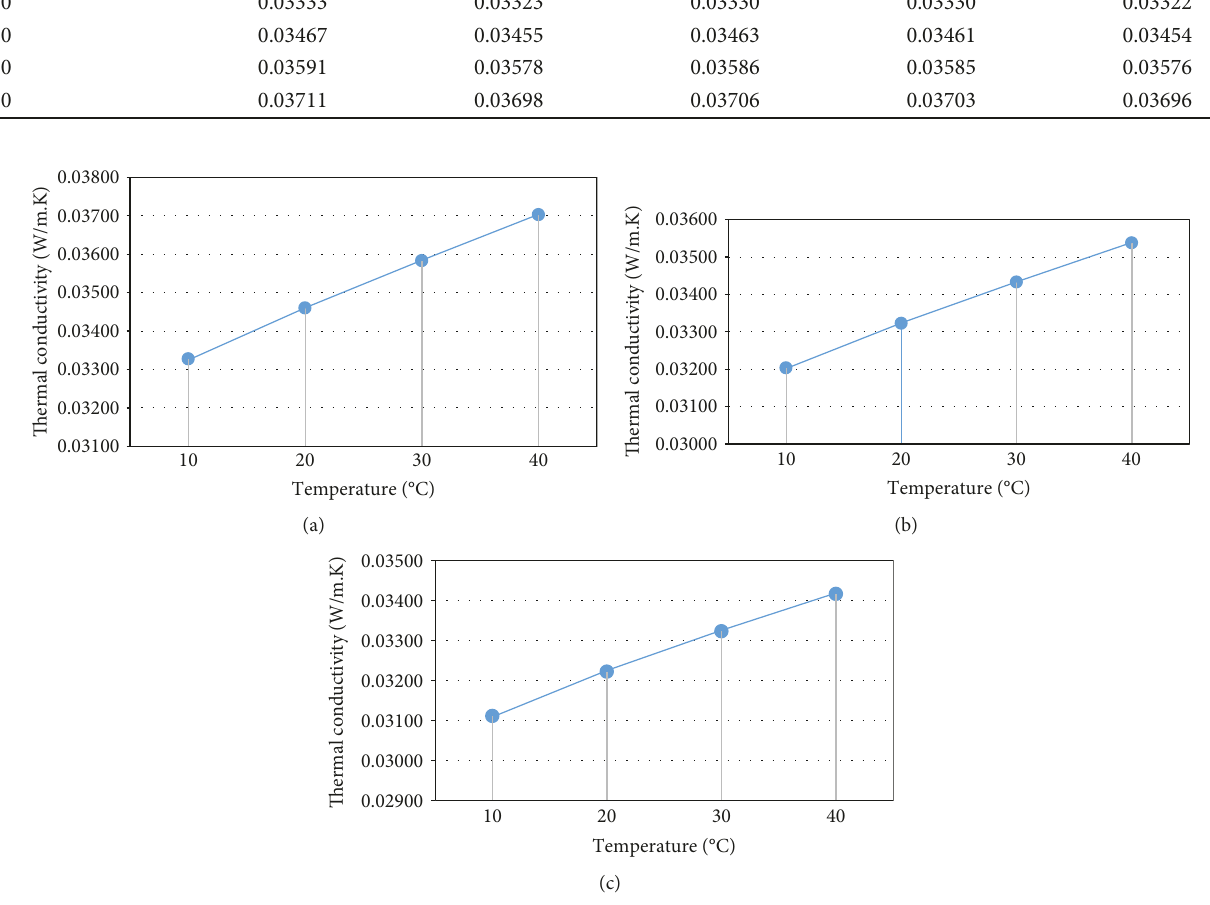
Figure 3: The change in the thermal conductivity of the expanded polystyrene with di ff erent density values with the varying temperatures